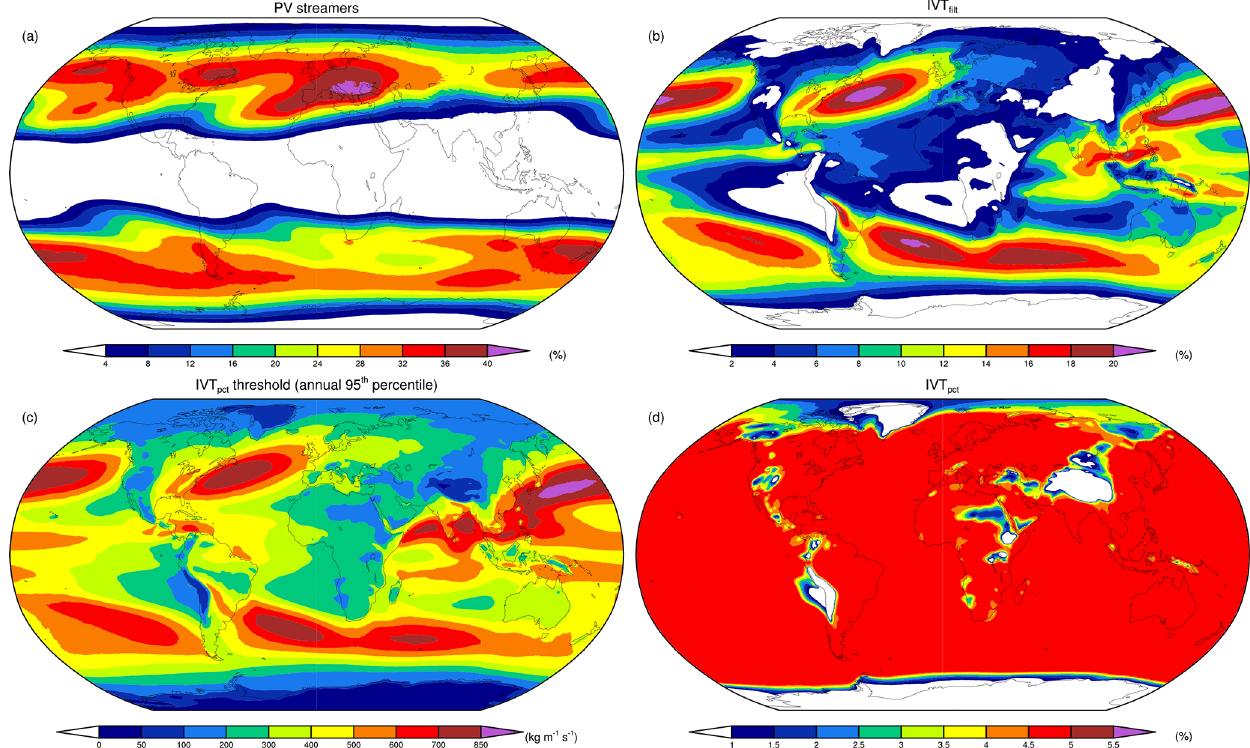
Figure 5. Climatological frequencies, based on 6-hourly occurrences for the period of 1979–2018, of (a) vertically aggregated stratospheric PV streamers between 300–350K, (b) IVT structures in the IVT filt form, and (d) IVT structures in the IVT pct form. In (c) IVT values (kgm − 1 s − 1 ) that correspond to the annual 95th percentiles of full IVT magnitudes used as threshold for the identification of IVT pct struc-